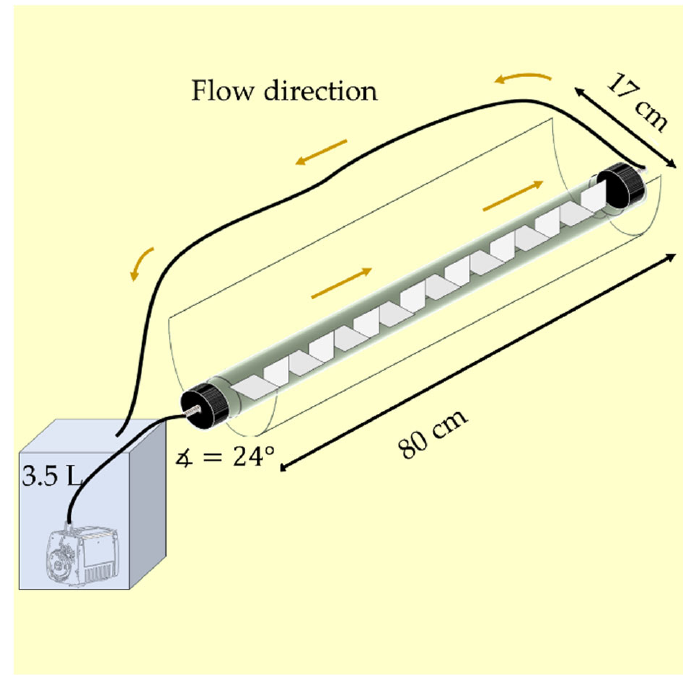
Figure 1. CPC reactor scheme.